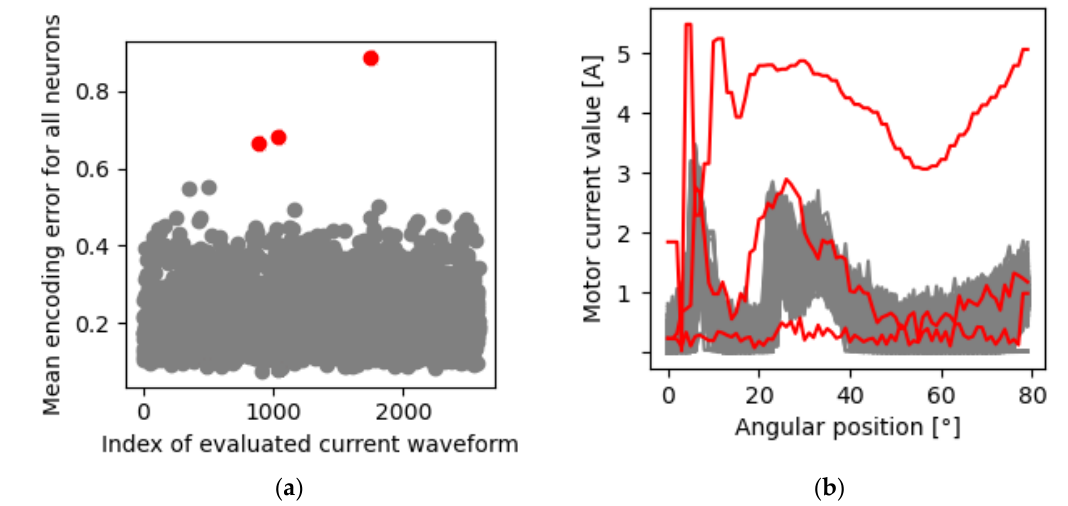
Figure 11. ( a ) Average mean squared error of autoencoder’s decoding for each waveform in the population; ( b ) Three most anomalous waveforms (red) selected with autoencoder from the population (grey).